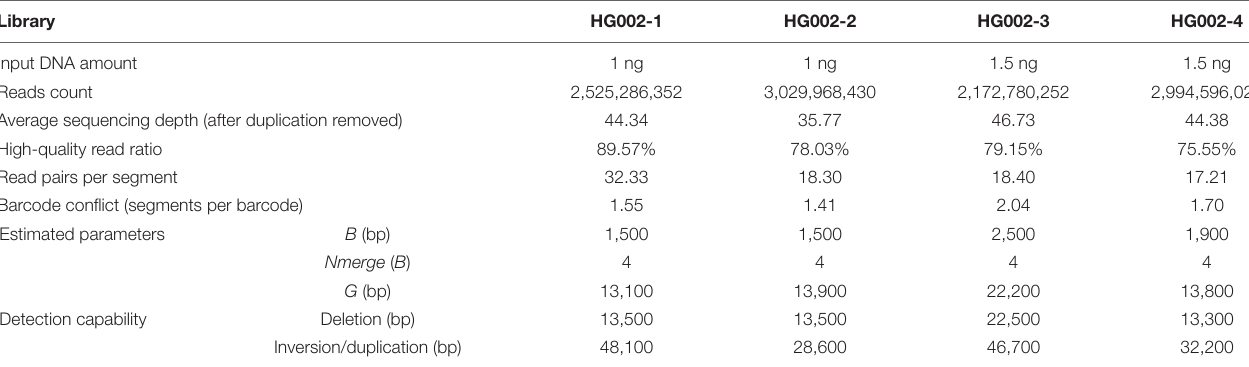
TABLE 2 | Detection capability and estimated parameters of different HG002